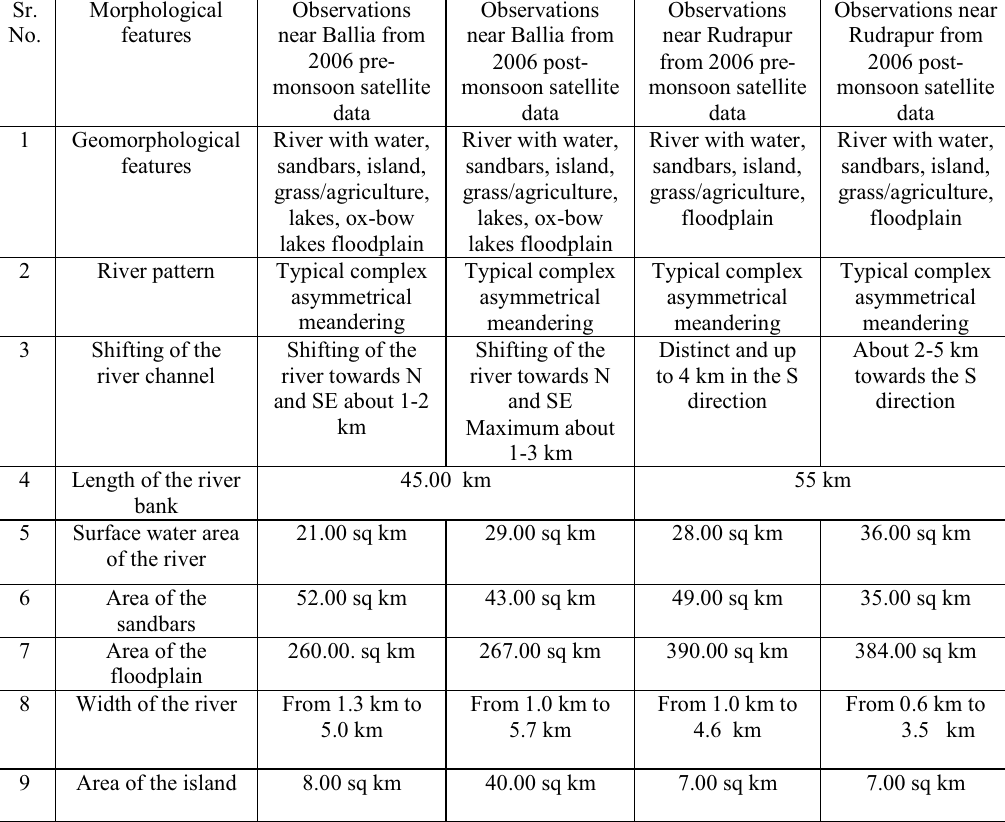
Table 2: Fluvial changes during